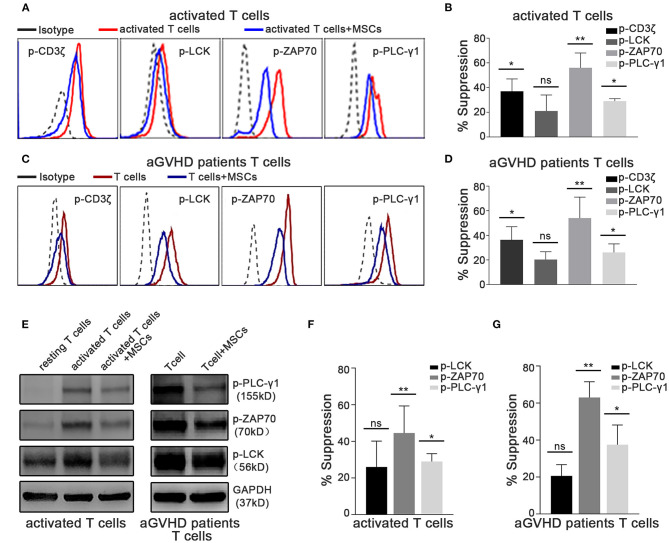
TCR-proximal signaling is altered rapidly in activated T cells cocultured with MSCs in vitro. The phosphorylation levels of CD3ζ, LCK, ZAP70, and PLC-γ1 were analyzed. Cocultures were established as described for Figure 1E. (A) Flow cytometric analysis of the phosphorylation levels of CD3ζ, LCK, ZAP70, and PLC-γ1 in cocultured and control activated T cells from healthy donors. (B) Column chart shows the suppression percentages of the phosphorylation levels by MSCs shown in (A). Data are presented as the means ± SEM from six donors. (C) Flow cytometric analysis of the phosphorylation levels of CD3ζ, LCK, ZAP70, and PLC-γ1 in cocultured and control T cells from aGVHD patients. (D) Suppression percentages of p-CD3ζ, p-LCK, p-ZAP70, and p-PLC-γ1 in T cells from patients after MSCs coculture. The data are presented as the means ± SEM from six patients. (E) Total cell lysates of T cells both from donors and patients were analyzed via western blotting of the listed phosphorylated proteins, with GAPDH detected as a loading control. A representative blot is shown. (F,G) Gray-scale values of blots in (E) were analyzed, the suppression percentages of listed phosphorylated proteins by MSCs are shown. Data are presented as the means ± SEM from three donors. Significant differences are indicated as follows: ns, no statistical significance; *p < 0.05 and **p < 0.01.